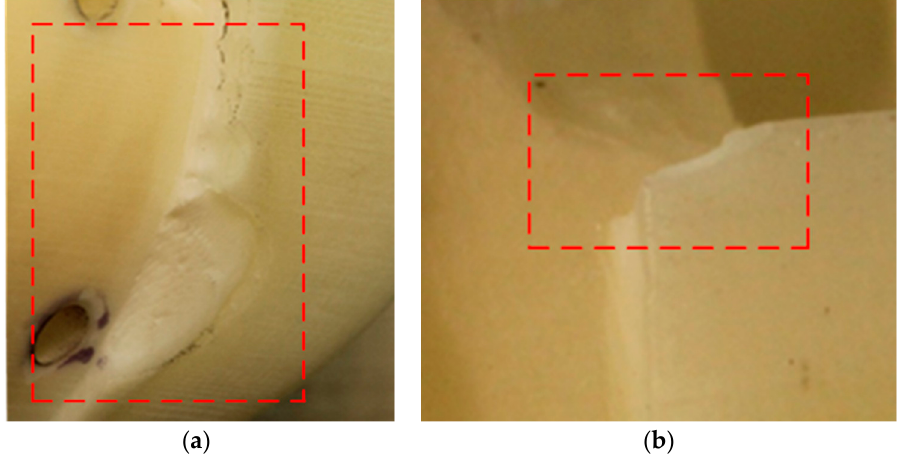
Figure 12. ( a ) Chipped edge of the tool caused during the ejection of the part. ( b ) Chipped corner of the tool due to injection pressure. See Figure 5 for the location on the tool.